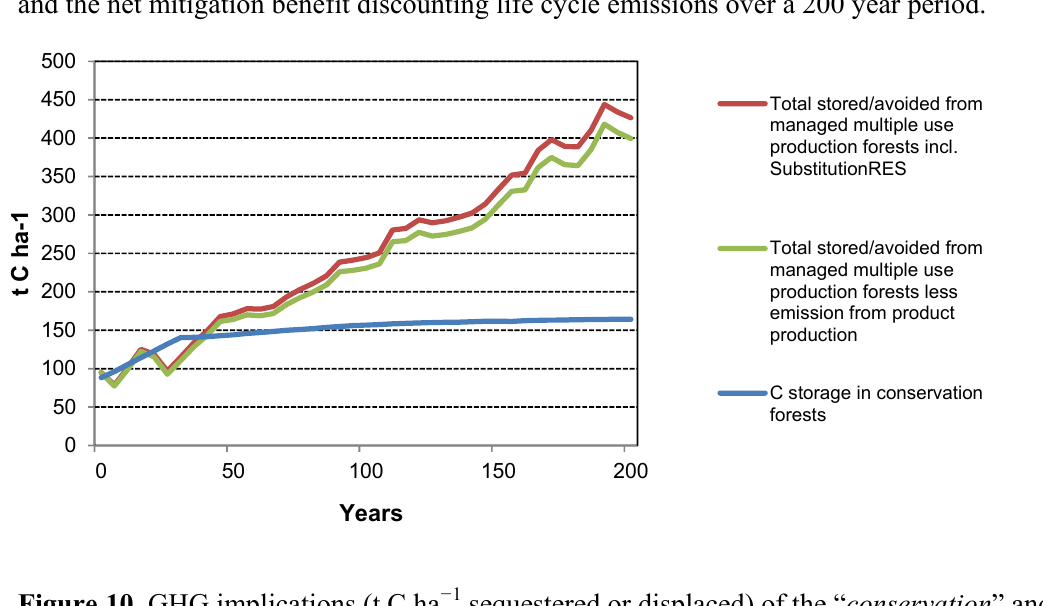
Figure 10. GHG implications (t C ha − 1 sequestered or displaced) of the “ conservation ” and “ production ” scenarios for SC